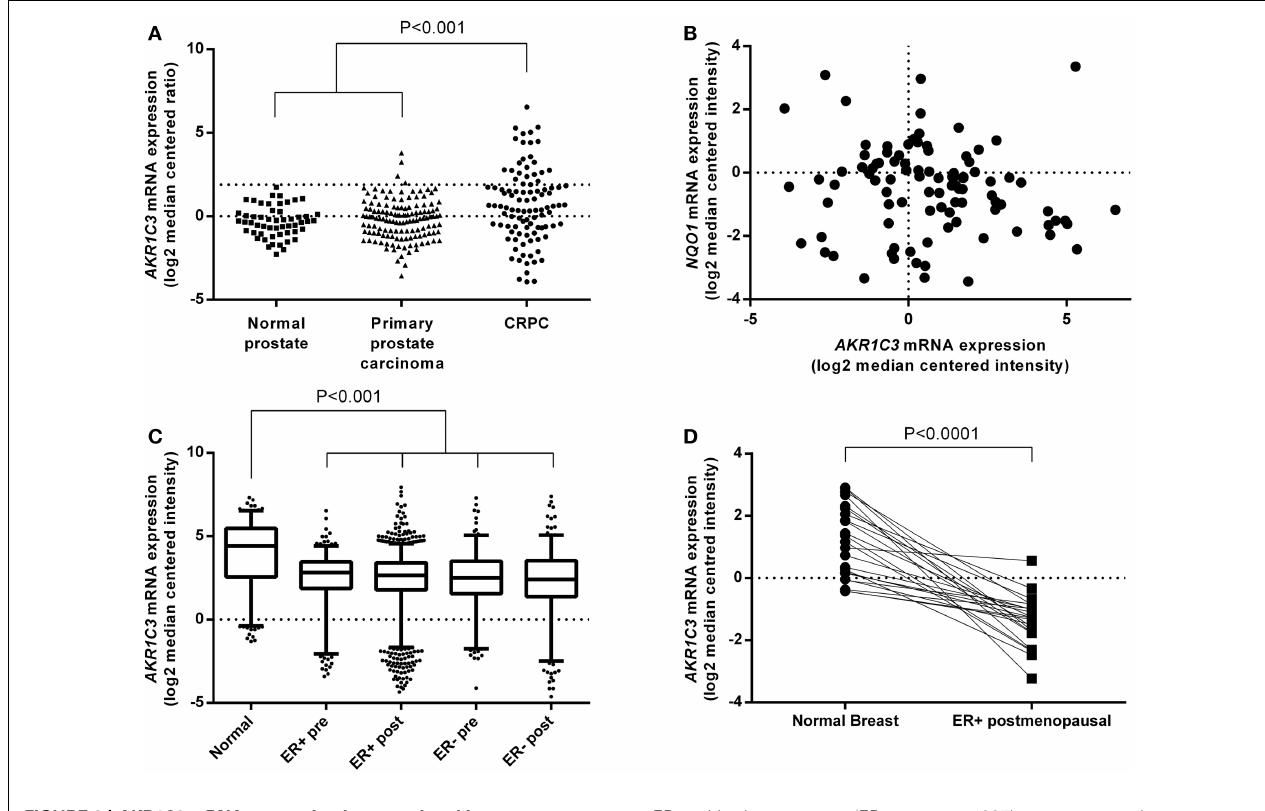
FIGURE 2 | AKR1C3 mRNA expression is upregulated in tumor samples from CRPC patients but downregulated in breast cancer patient tumors . (A) Meta-analysis of AKR1C3 mRNA expression in normal prostate ( n = 54), primary prostate carcinoma ( n = 133), and CRPC ( n = 100) tissue in patients from seven Oncomine prostate cancer datasets.The upper dotted line indicates 75th percentile for CRPC. (B) Correlation of NQO1 mRNA expression with AKR1C3 mRNA expression in CRPC patients from (A) . (C) Meta-analysis of AKR1C3 mRNA expression in normal breast (Normal, n = 257), premenopausal ER-positive breast cancer (ER + pre, n = 281), post-menopausal